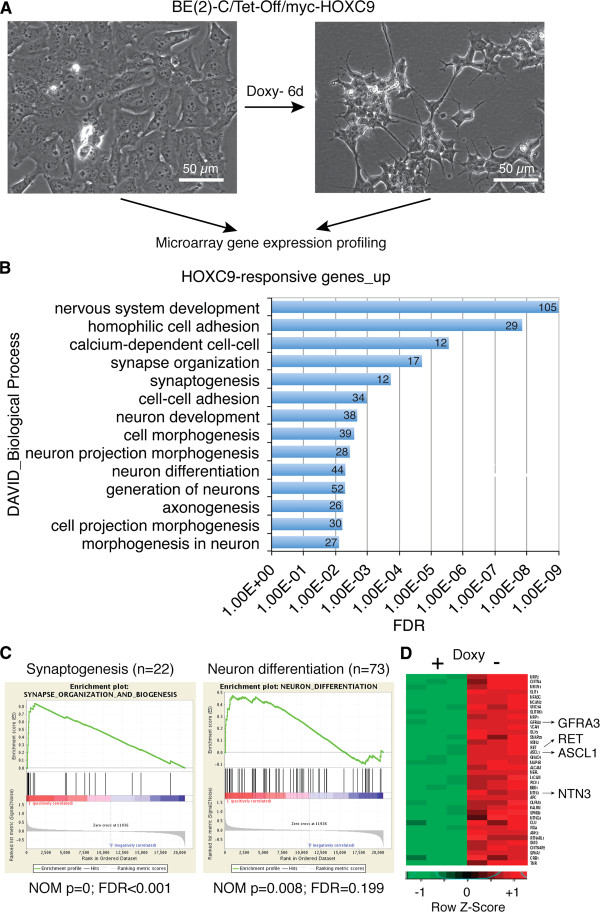
Global upregulation of neuronal genes by HOXC9. (A) Schematic of experiment. Doxy, doxycycline. (B) DAVID analysis of upregulated HOXC9-responsive genes for enriched GO biological process categories (enrichment fold > 2.0; FDR <1%). The number of genes for each biological process category is indicated. (C) GSEA showing significant enrichment of gene sets involved in synapse organization and biogenesis and neuron differentiation among the genes upregulated by HOXC9. (D) Heatmap of select neuronal genes activated by HOXC9.